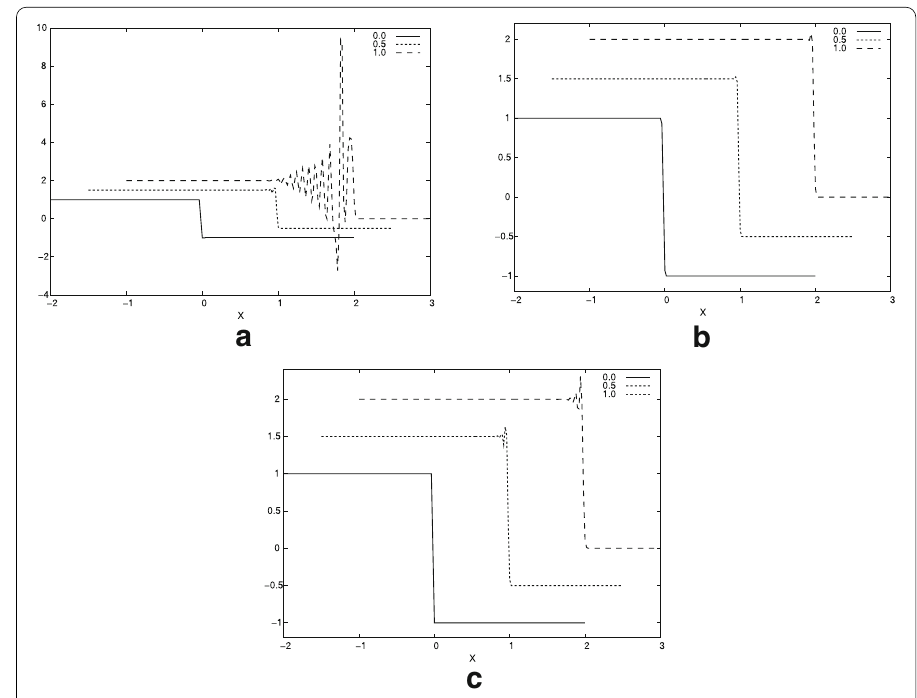
Fig. 24 Profiles of u versus x , with λ = 0 , λ = 0 . 5 and λ = 1, at t = 1s. a FTCS scheme. b